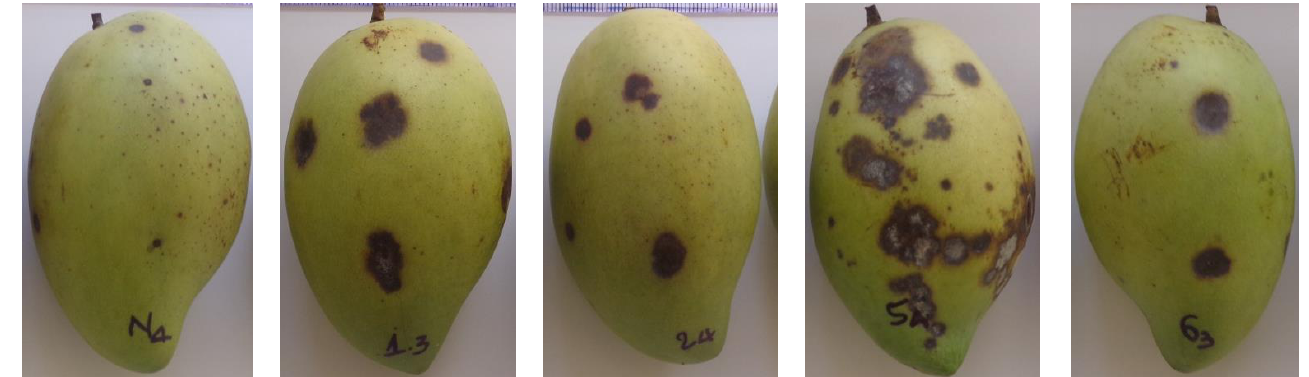
Figure 1. Anthracnose symptoms on Cat Hoa Loc mango fruits artificially infected by sterile distilled water, Col 1, Col 2, Col 5, and Col 6 strains (from left to right ) at 15 days after artificial infection.